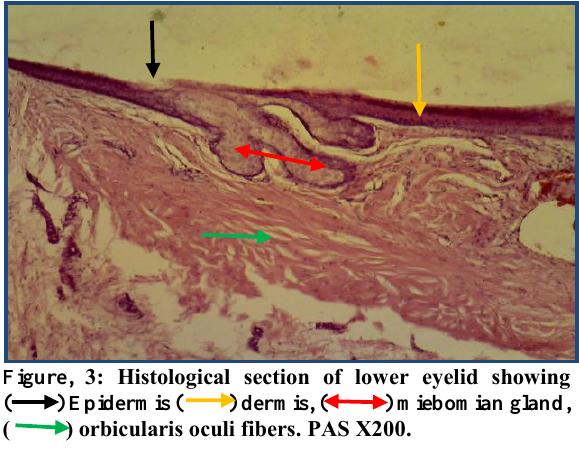
Figure, 3: Histological section of lower eyelid showing